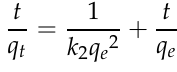
Figure 9. Time variation trends of the dye adsorption capacities of the two adsorbents at different pH values and temperatures: ( a ) pH 3 and 333 K, ( b ) pH 12 and 333 K, ( c ) pH 3 and 303 K, and ( d ) pH 12 and 303 K ( ■ CS, ● CSGO).